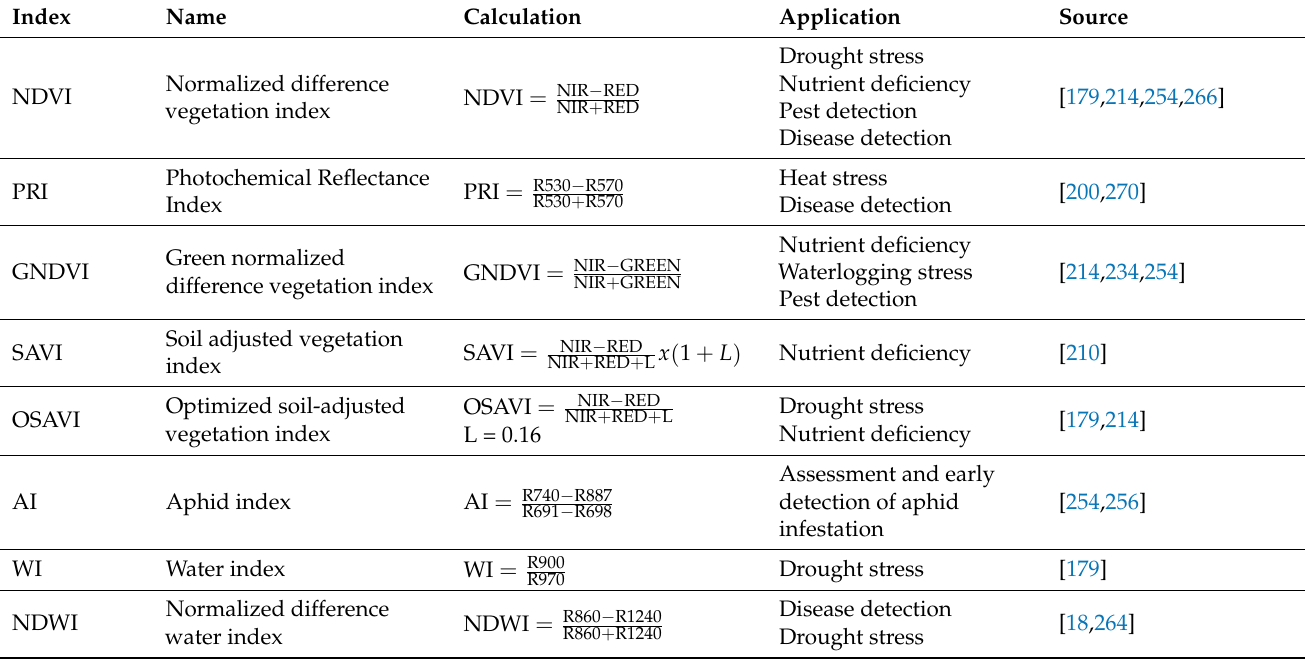
Table 1. Vegetation indices used for environmental stress detection and evaluation in winter wheat